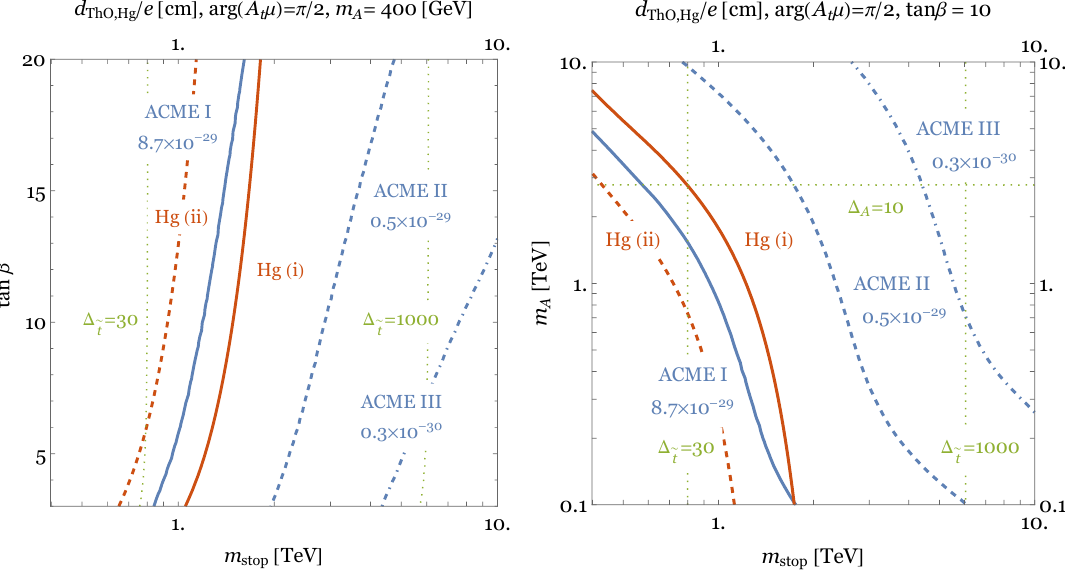
Figure 10 . EDM constraints on stop parameter space. This is very similar to (cid:12)gure 9, except that we no longer assume the MSSM, so the A -term is not constrained by the Higgs boson mass. Instead, we take into account the expected size of an A -term induced by RG running from the gluino mass, as in (5.8). The red solid and dashed contours (\Hg (i)" and \Hg (ii)") denote the mercury EDM constraint for the two nuclear physics computations discussed in appendix